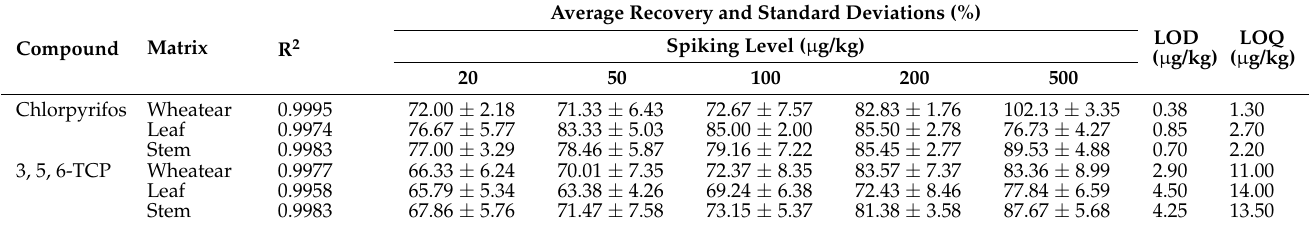
Table 3. R 2 , recoveries, LOD and LOQ of chlorpyrifos and its metabolite 3, 5, 6-TCP in different matrices ( n = 5). Values (mean ± SD) in the same